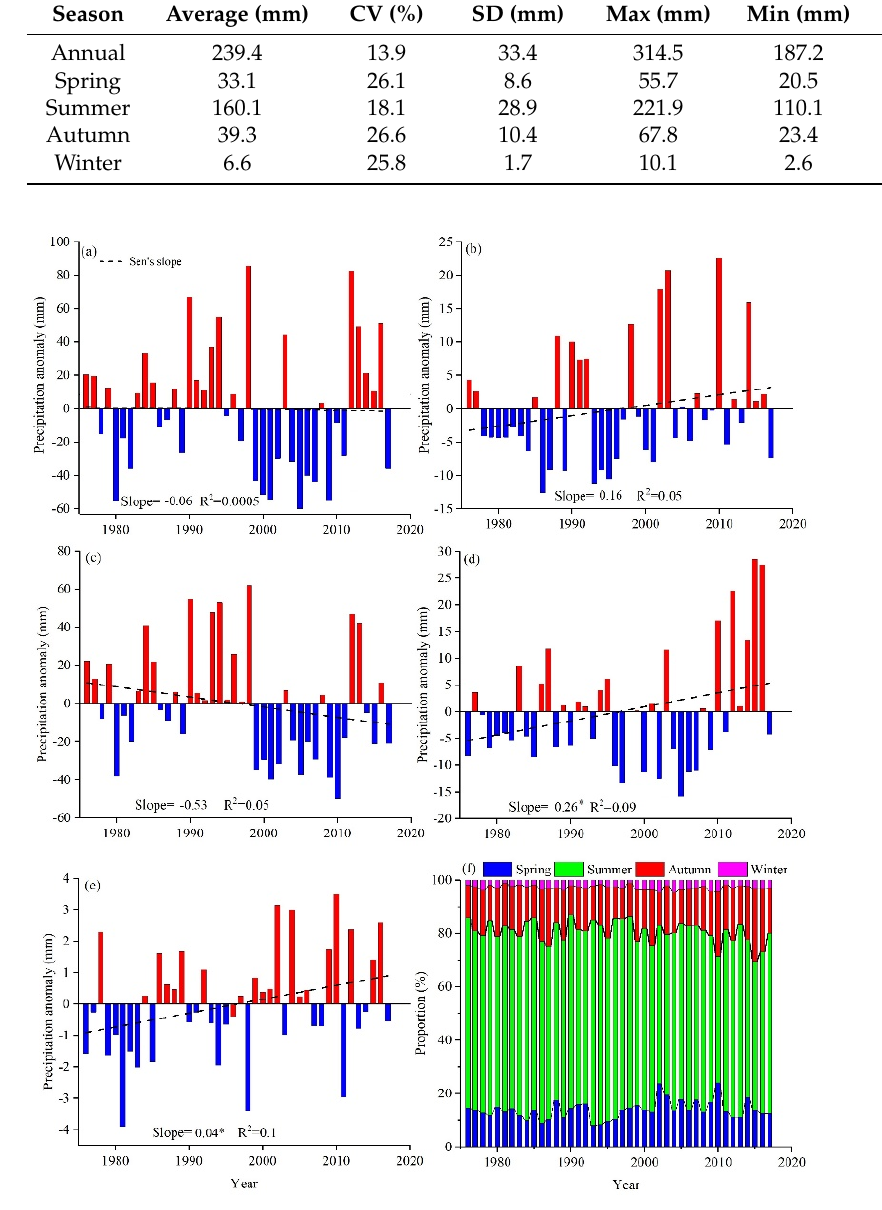
Figure 2. Variability of anomalies of annual and seasonal precipitation (( a ) Annual, ( b ) Spring, ( c ) Summer, ( d ) Autumn, ( e ) Winter) and the ( f ) percentage of annual precipitation in each season during 1976–2017 in the Mongolian Plateau (* indicates p < 0 .05 ).